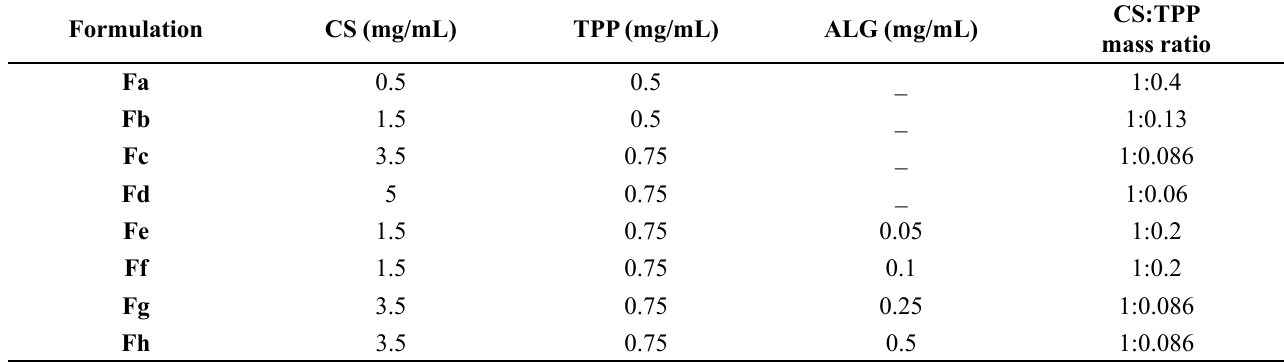
TABLE I - Preparative characteristics of the different formulations